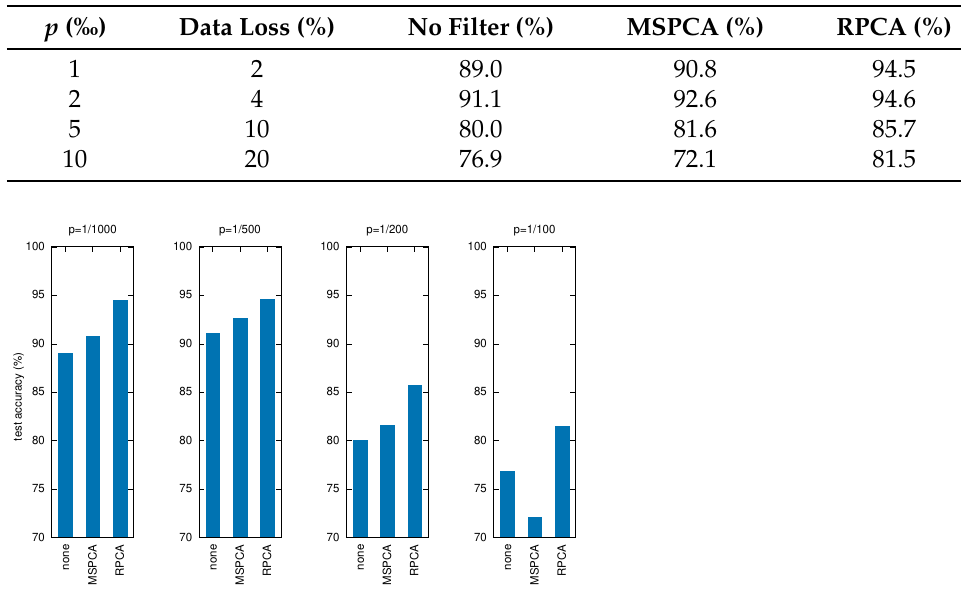
Table 6. Test accuracy for corrupted signals with different filtering techniques ( p is the corruption probability, data loss represent the average number of missing samples).